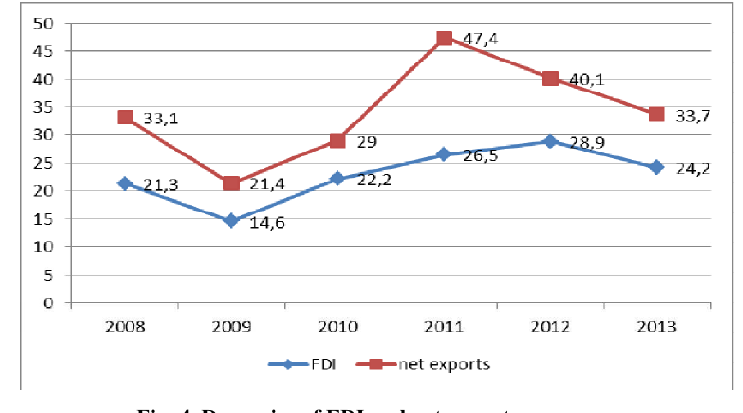
Fig. 4. Dynamics of FDI and net exports